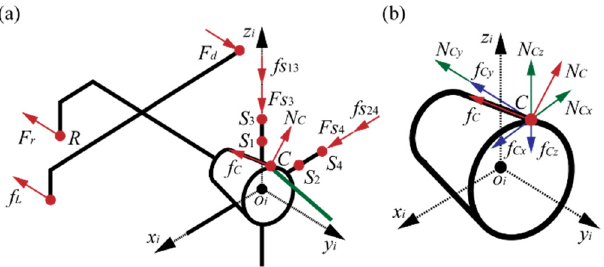
Figure 11. Free-body diagram of “contact and alignment I”: ( a ) the mechanical analysis of the drogue (the green line represents the probe), ( b ) the orthogonal decomposition of the contact forces.